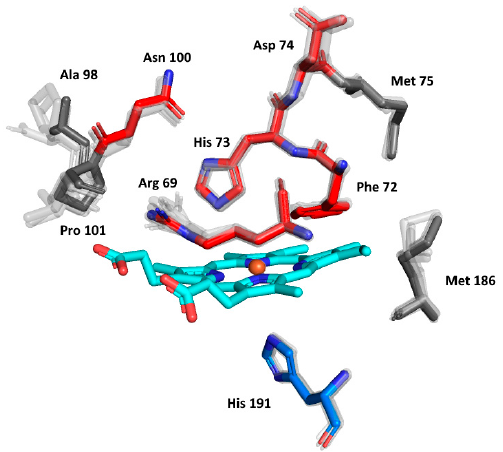
Figure 7. Structural presentation of a 3D model of the active centre in ScepHyBpox1 reconstructed with AlphaFold 2 [25]. Models of active centres for six ancestors from nodes A–F (cf. Figure 3) are also superimposed. Colour scheme: cyan—prosthetic heme group, red—residues involved in the catalytic machinery on the distal side, blue—proximal histidine.